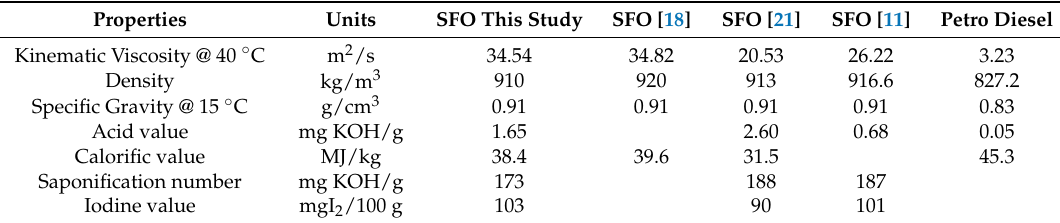
Table 2. Physical and chemical properties of